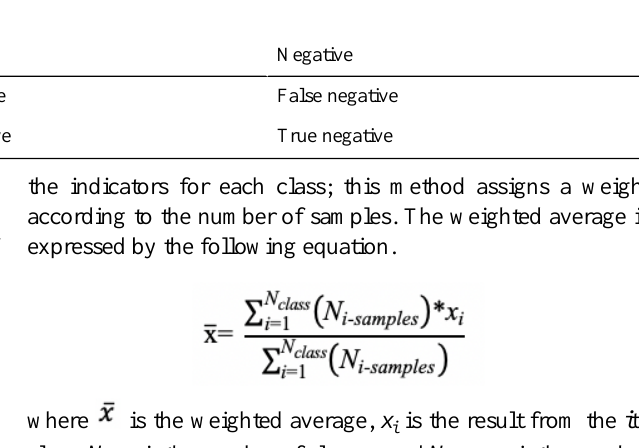
Table 2. Confusion matrix for binary classification.